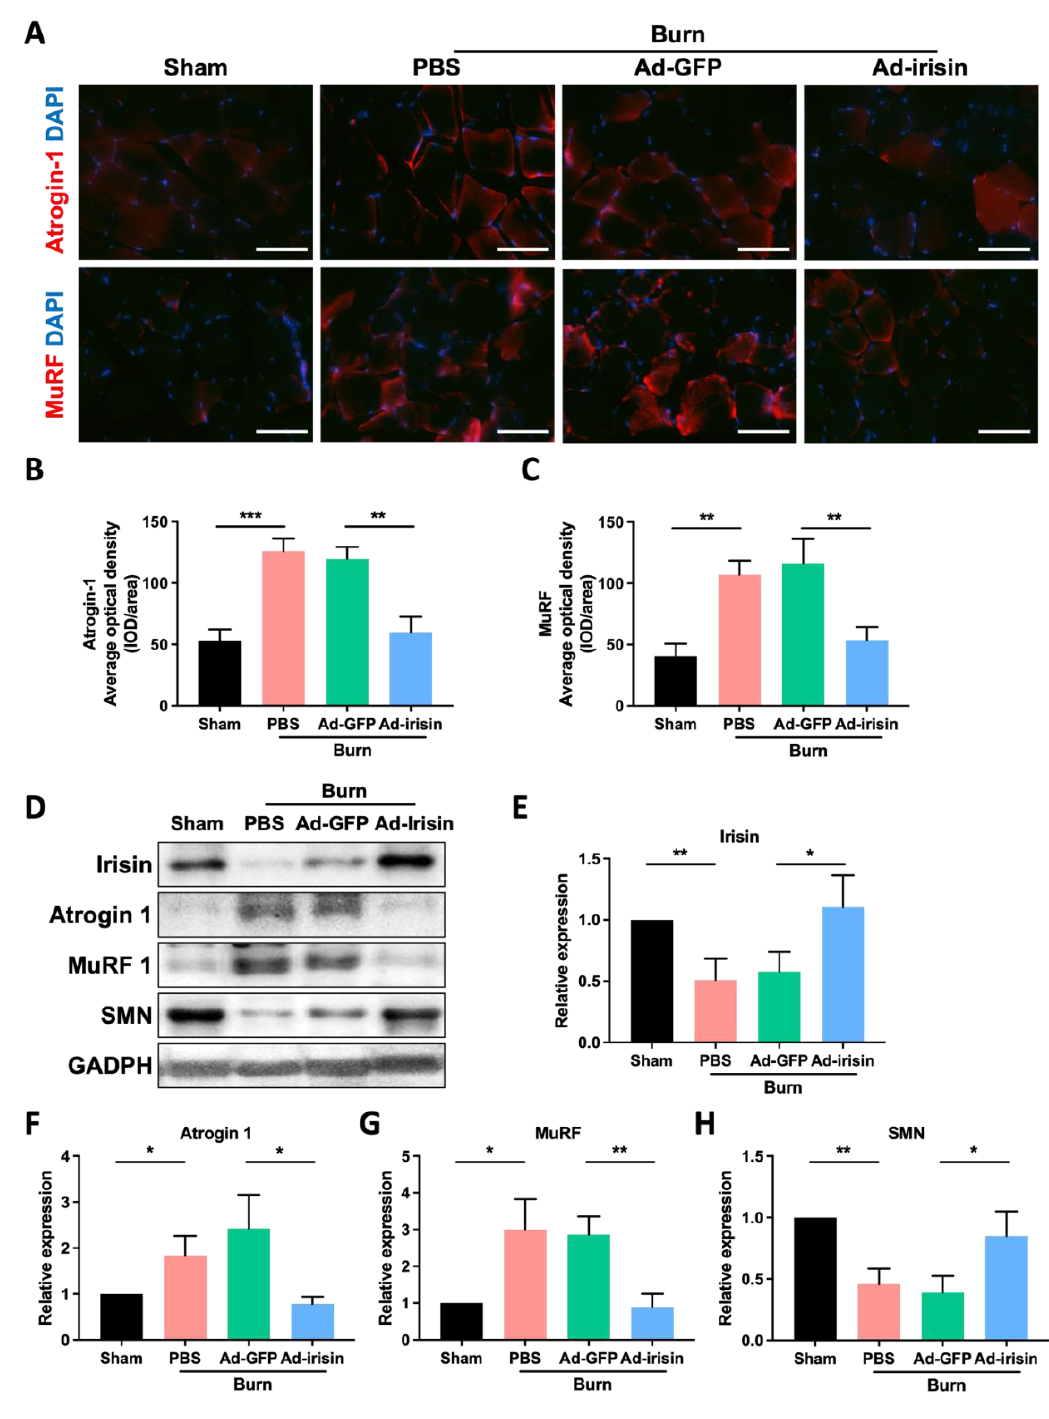
Figure 2. Spinal irisin gene delivery attenuated burn injury-induced atrophy markers and reduced irisin and SMN expression in ipsilateral gastrocnemius muscle. ( A ) Immunofluorescence staining of atrogin-1 and MuRF in ipsilateral gastrocnemius muscle in the fourth week after burn injury. DAPI counterstain was used to locate the nucleus. ( B , C ) Representative bar graphs illustrating averaged optical intensity of atrogin-1 and MuRF. Error bars represent standard deviations (SDs). ** p < 0.01, *** p < 0.001, unpaired t-test. ( D ) Immunoblot of ipsilateral gastrocnemius muscle tissue in the fourth week after burn injury. ( E – H ) Representative bar graphs illustrating normalized expression ratio of irisin, atrogin-1, MuRF, and SMN, with GAPDH as an internal control. Error bars represent SDs. * p < 0.05, ** p < 0.01, unpaired t-test.